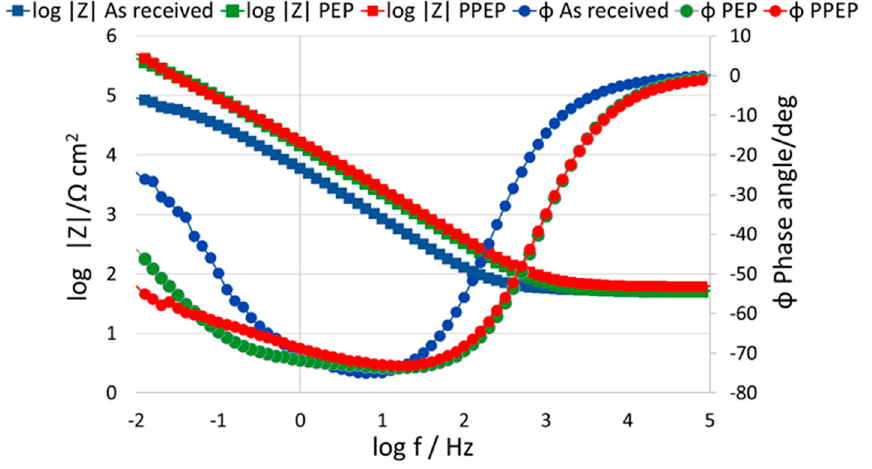
Figure 4. Bode plots for tested surface conditions.